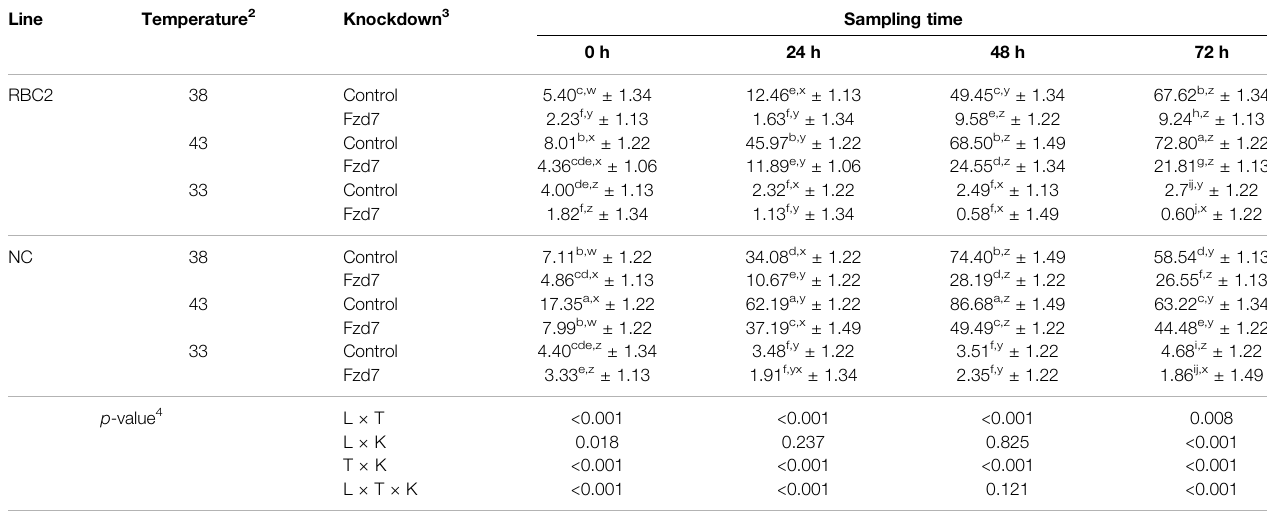
TABLE 3 | Effect of temperature and knockdown of frizzled-7 ( Fzd7 ) on differentiation of randombred control line 2 (RBC2) and modern commercial line (NC) satellite cells 1 .